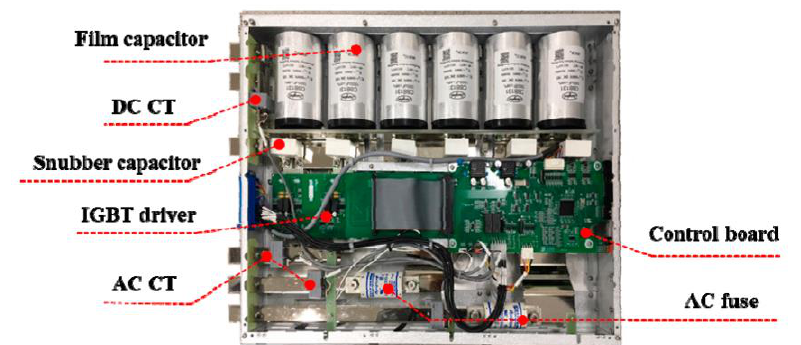
Figure 11. Image of the 125 kW power stack.